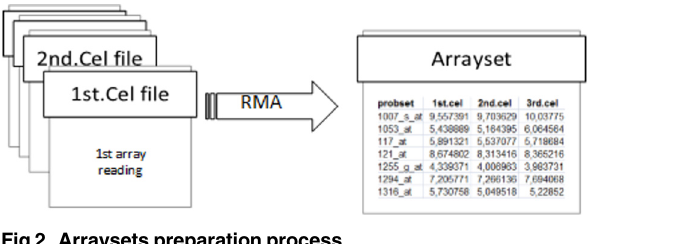
Fig 2. Arraysets preparation process.